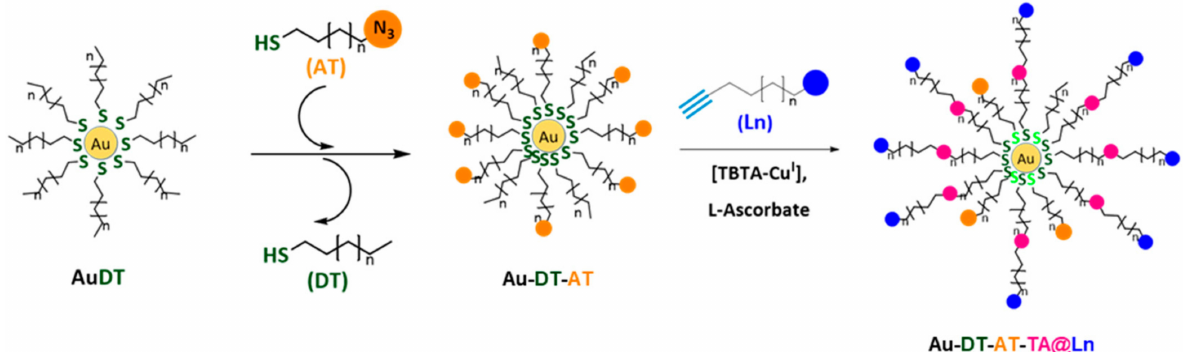
Figure 2. Representation of ligand exchange reaction of AuDT with 11-azidoundecane-1-thiol to form AuDT-AT nanoparticle templates and representation of azide-alkyne Huisgen cycloaddition of AuDT-AT and L n dendrons to form AuDT-AT-TA@L n metalorganic hybrids.